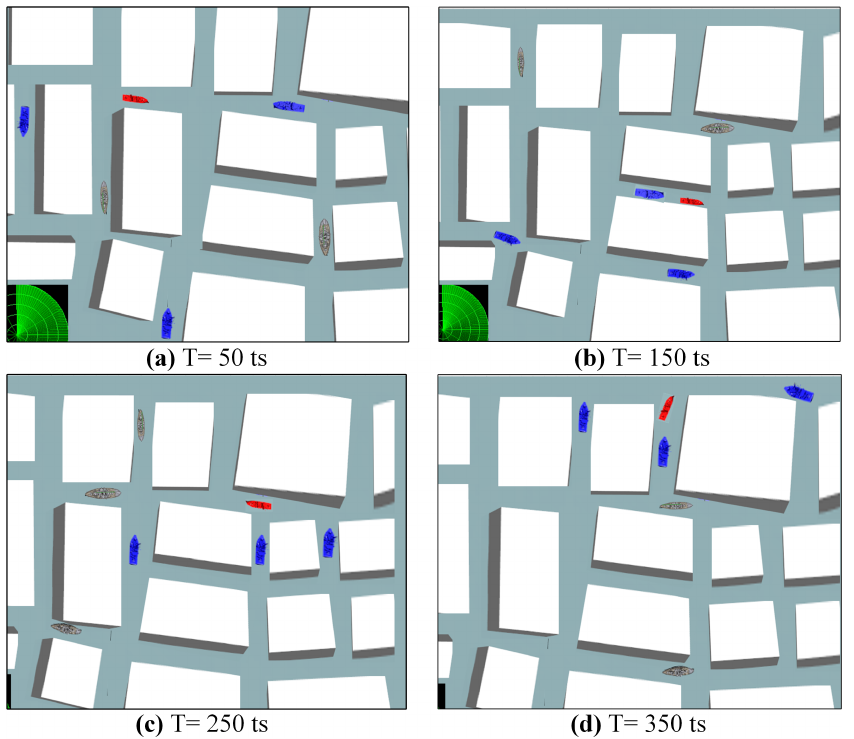
Figure 11. Sample capture process of three-USV team at different time steps (ts) with speed of 3 m · s − 1 for both USVs and intruder and a 200 meter detection